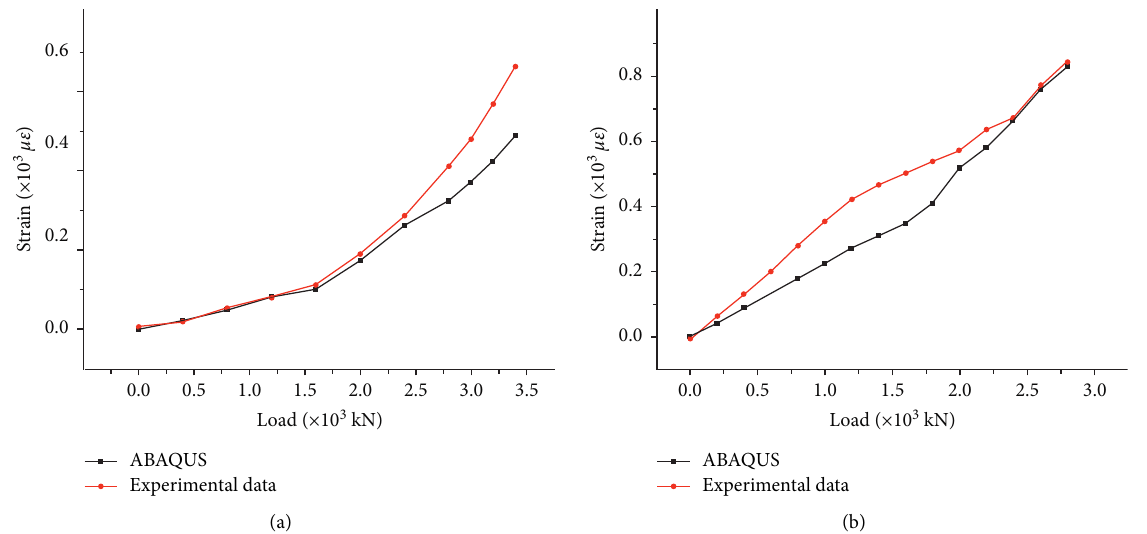
Figure 18: Comparison of the strain-load curves of experiment and of calculated by finite element method: (a) the top of the side column; (b) the middle in the right side of the